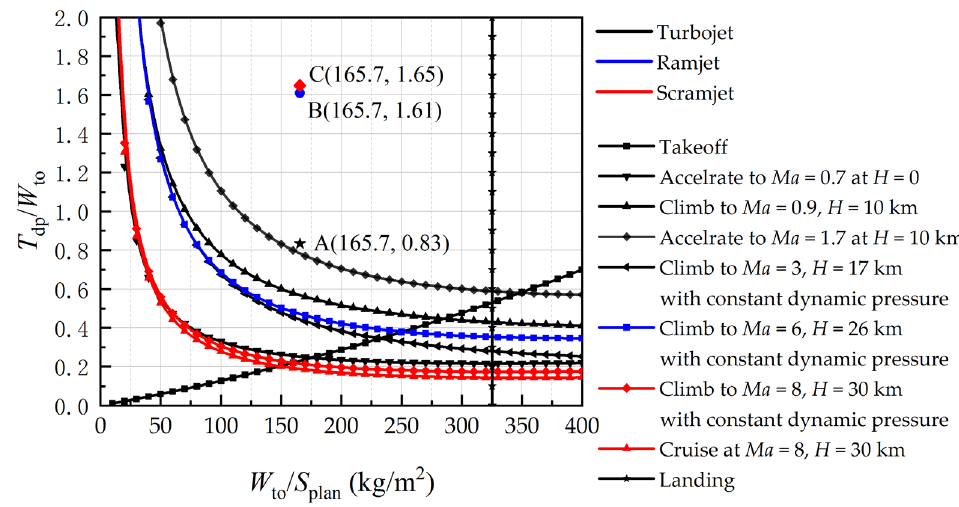
Figure 10. Constraint analysis plot.